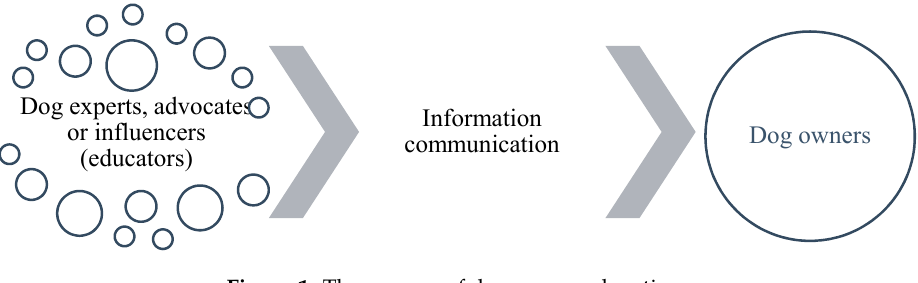
Figure 1. The process of dog owner education.